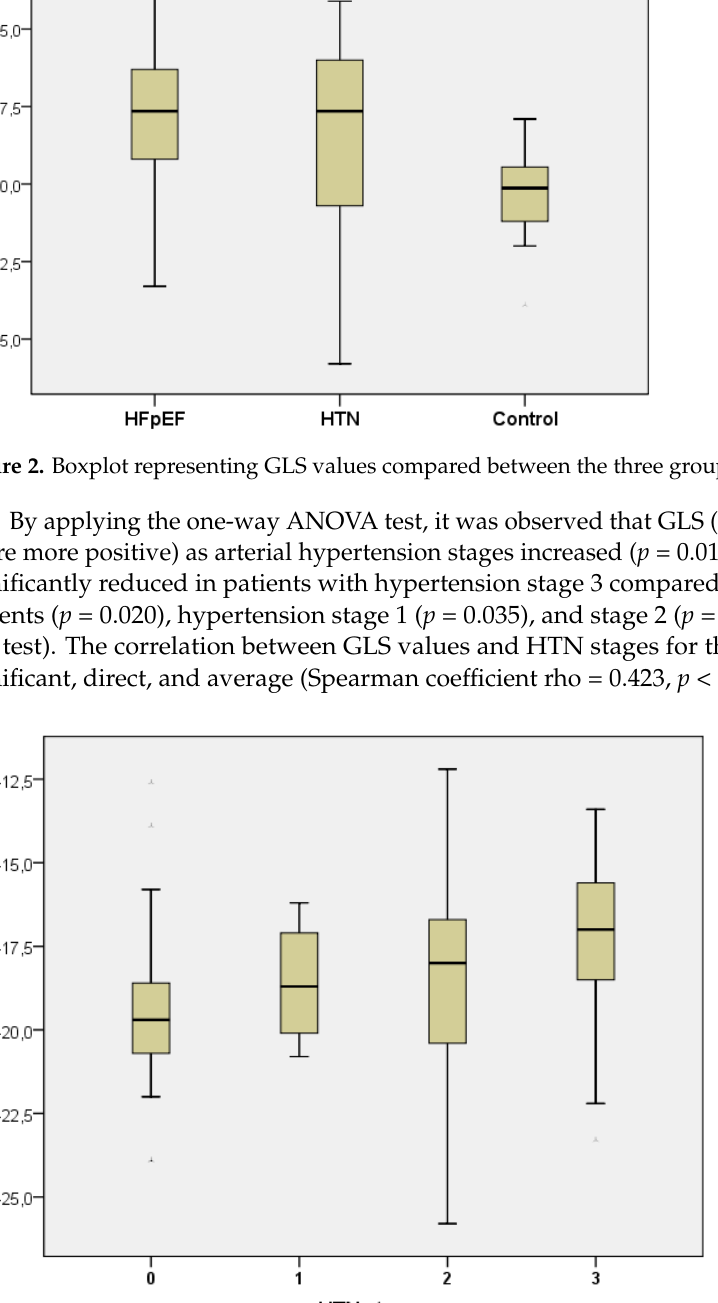
Figure 3. Boxplot for GLS values, comparing HTN stages in all patients vs. CON ( n = 148). In 2D speckle-tracking echocardiography, the HFpEF group showed a marked reduc- tion in segmental LS compared with the hypertension group or age-matched control group at basal level ( p = 0.017 for septal region, p = 0.025 for lateral region, p = 0.020 for anterior region and p = 0.019 for inferior region) (Figure